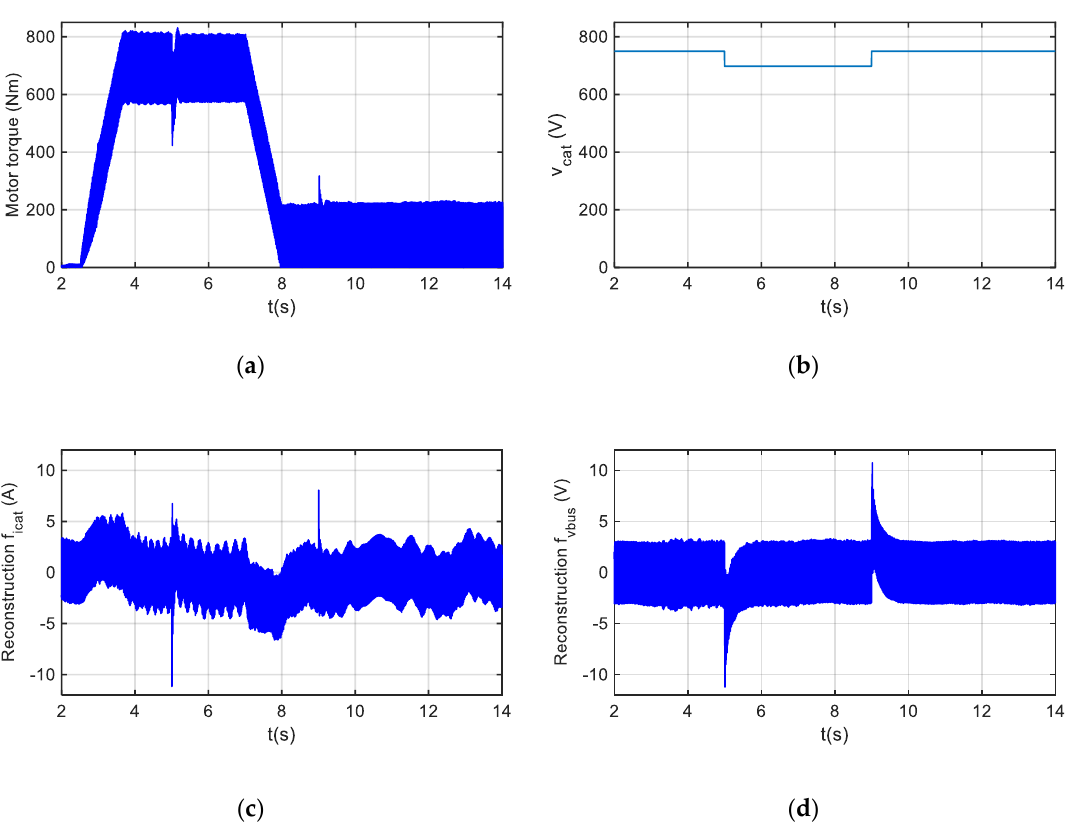
Figure 6. Fault reconstructions for a sensor fault-free scenario with a catenary voltage drop. ( a ) Motor torque. ( b ) Catenary voltage. ( c ) Catenary current sensor fault reconstruction. ( d ) DC-link voltage sensor fault reconstruction.